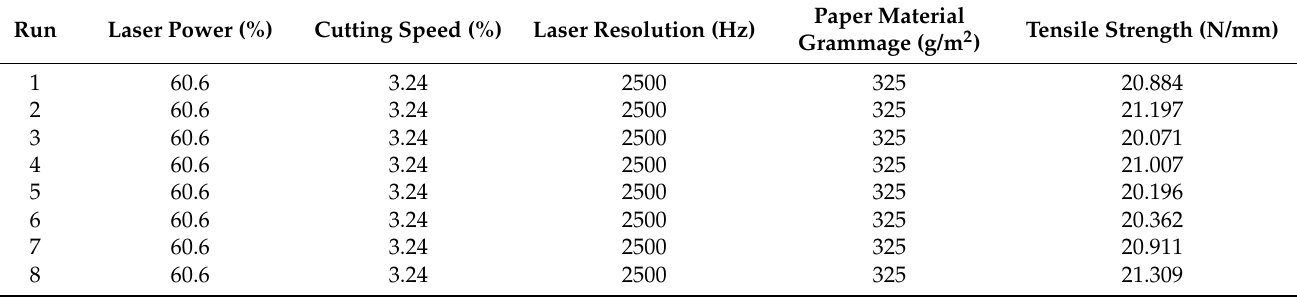
Table 8. Experimental verification of the optimized